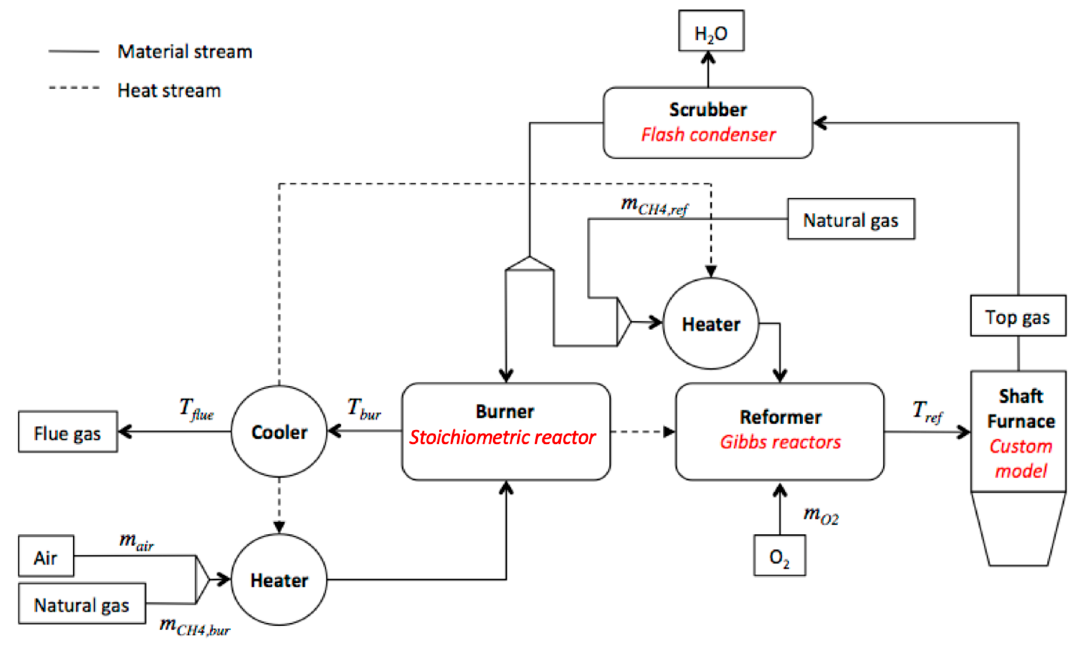
Figure 2. Modeled MIDREX process flow diagram, with its gas loop.